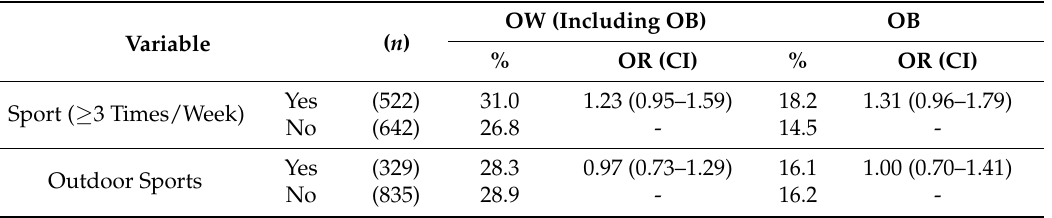
Table 4. Exercise/sport practised by the children in the MAPEC_LIFE